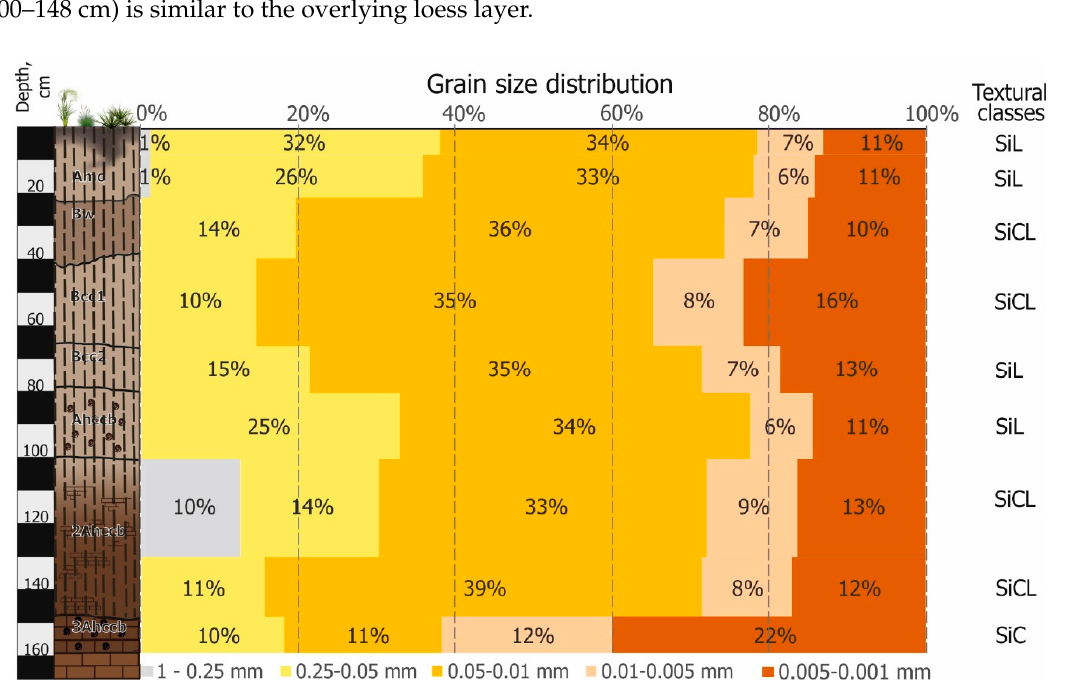
Figure 10. Grain size distribution in Calcic Kastanozem, Srednaya Akhtuba section .